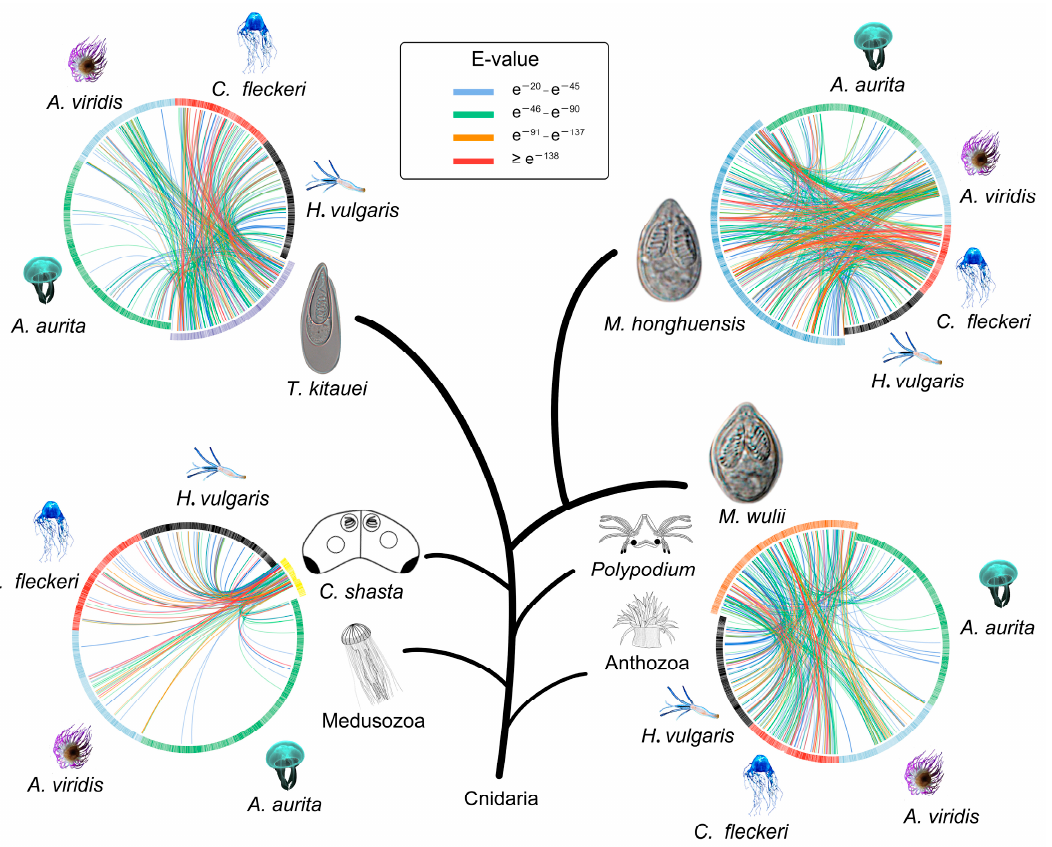
Figure 3. Circos representation of the sequence similarities of identified nematocyst proteins from the four myxozoan models with published free-living cnidarian nematocyst proteomes ( − e value 1 × 10 − 20 ). Colored lines represent similarity scores, with the corresponding E-values denoted in the